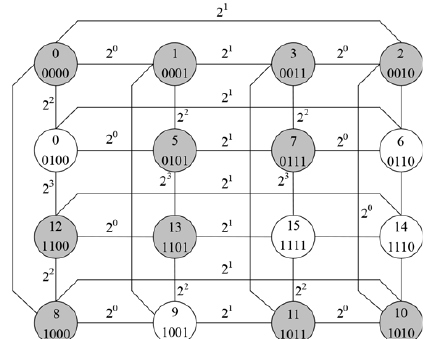
Fig. 1. Perfect matrix placement of a 4-dimensional cube 4 E The minimization of the